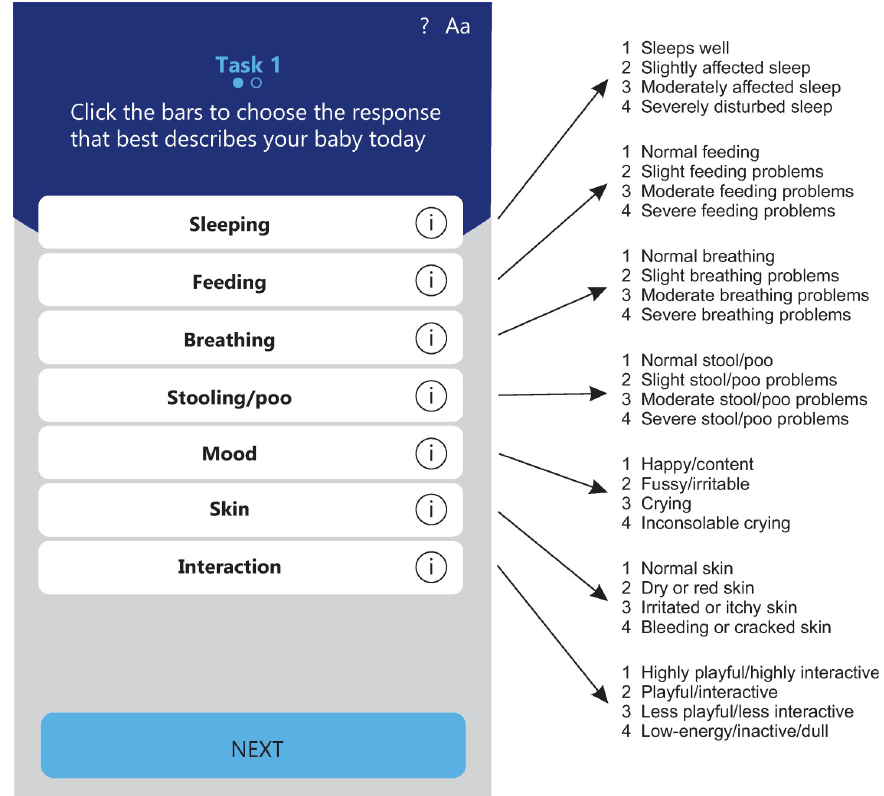
Fig 1. Infant Quality of life Instrument (IQI) health items and their levels (left: screenshot of the mobile application for the IQI).